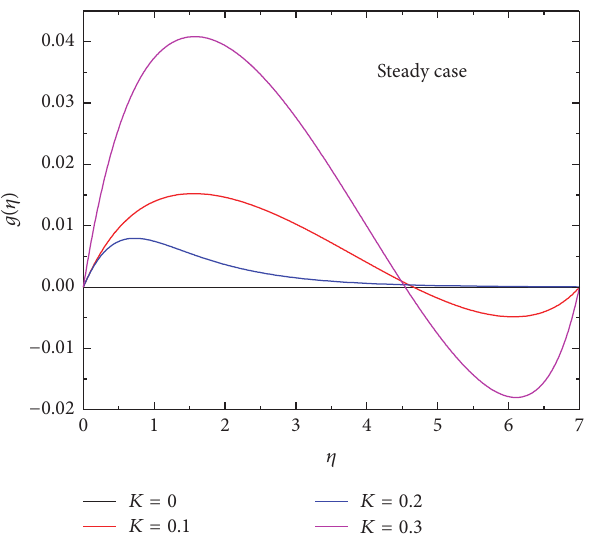
Physically it means that there is a reversed flow for this